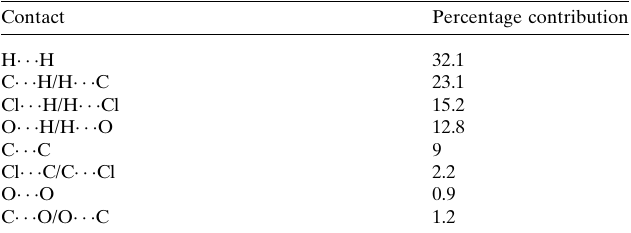
Table 2 Percentage contributions of various contacts to the Hirshfeld surface. Contact